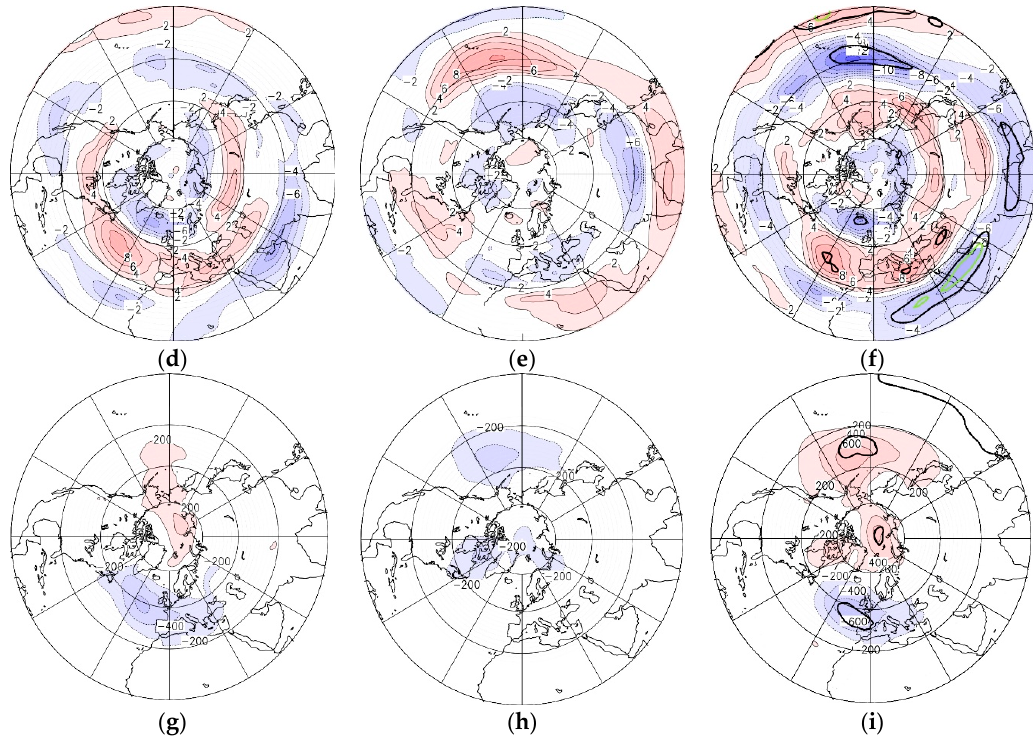
Figure 7. Mean composites of geopotential height (GH) anomaly (m) ( a–c,g–i ) and zonal wind anomaly (m/s) ( d–f ) for strong ‐ PJO ( left column ), for non ‐ PJO ( middle column ), and difference of strong ‐ PJO minus non ‐ PJO ( right column ) for ERA ‐ Interim at 300 hPa ( a–f ) and 1000 hPa ( g–i ) during 15 days after CD. Thick black (green) line in ( c ) includes areas of significant differences with student t ‐ test of 80% (90%) confidence.